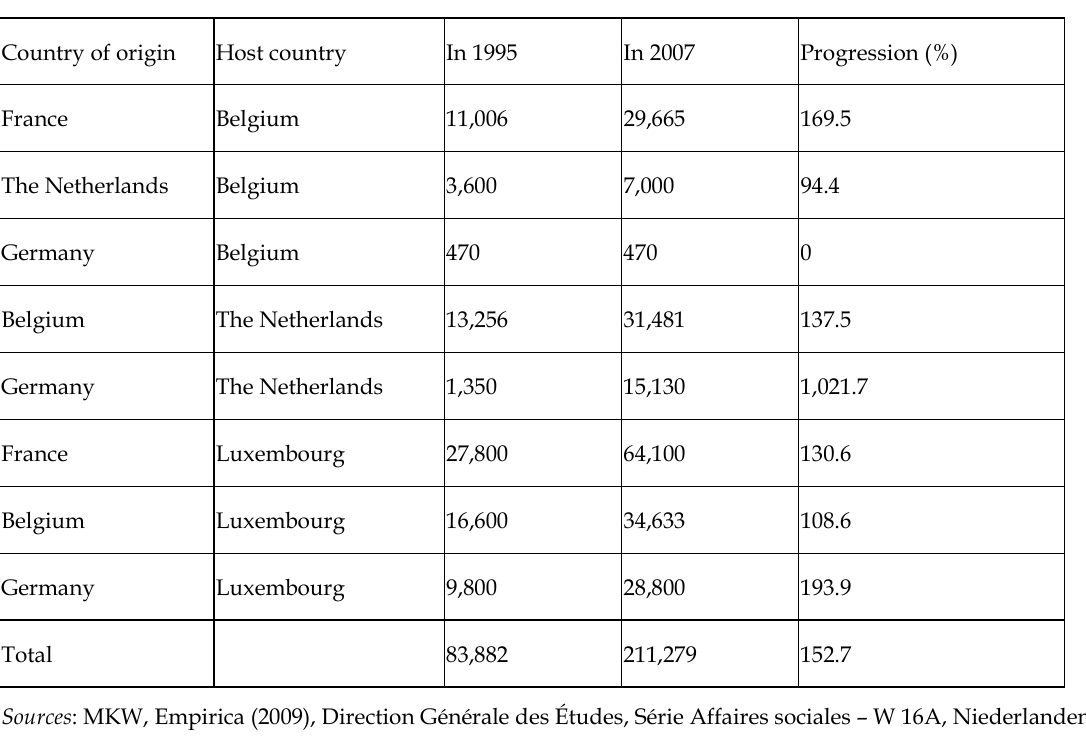
Table 2. Cross-border commuters in